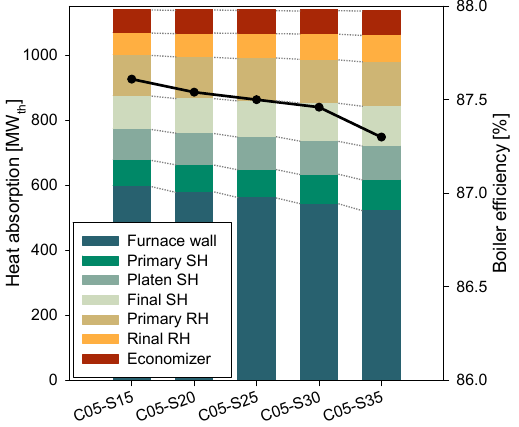
Figure 9. Comparison of heat absorption by heat exchangers and boiler efficiency for different SOFA ratios (CCOFA ratio fixed at 5%).